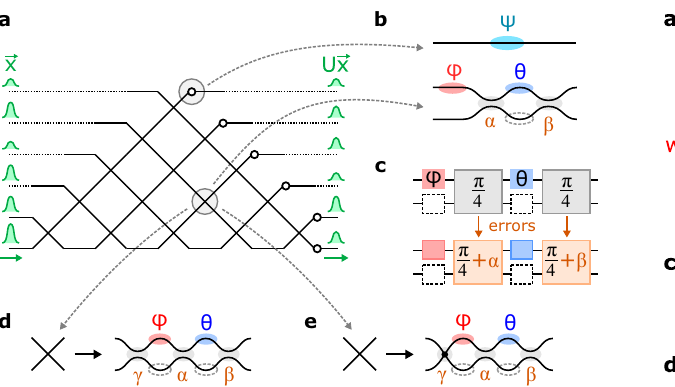
Fig. 1 | Multiport interferometers withimperfect components. a Universal6×6 circuitrealizedbyatriangular(Reck 1 )mesh. b Constituentcomponentsofthemesh include phase shifters ( ψ ) and programmable MZI couplers ( θ , ϕ ). c Fabrication imperfections lead to splitting-ratio errors α , β . d , e Alternative error-resilient coupler designs proposed in this paper: d 3-splitter MZI and e MZI+crossing.